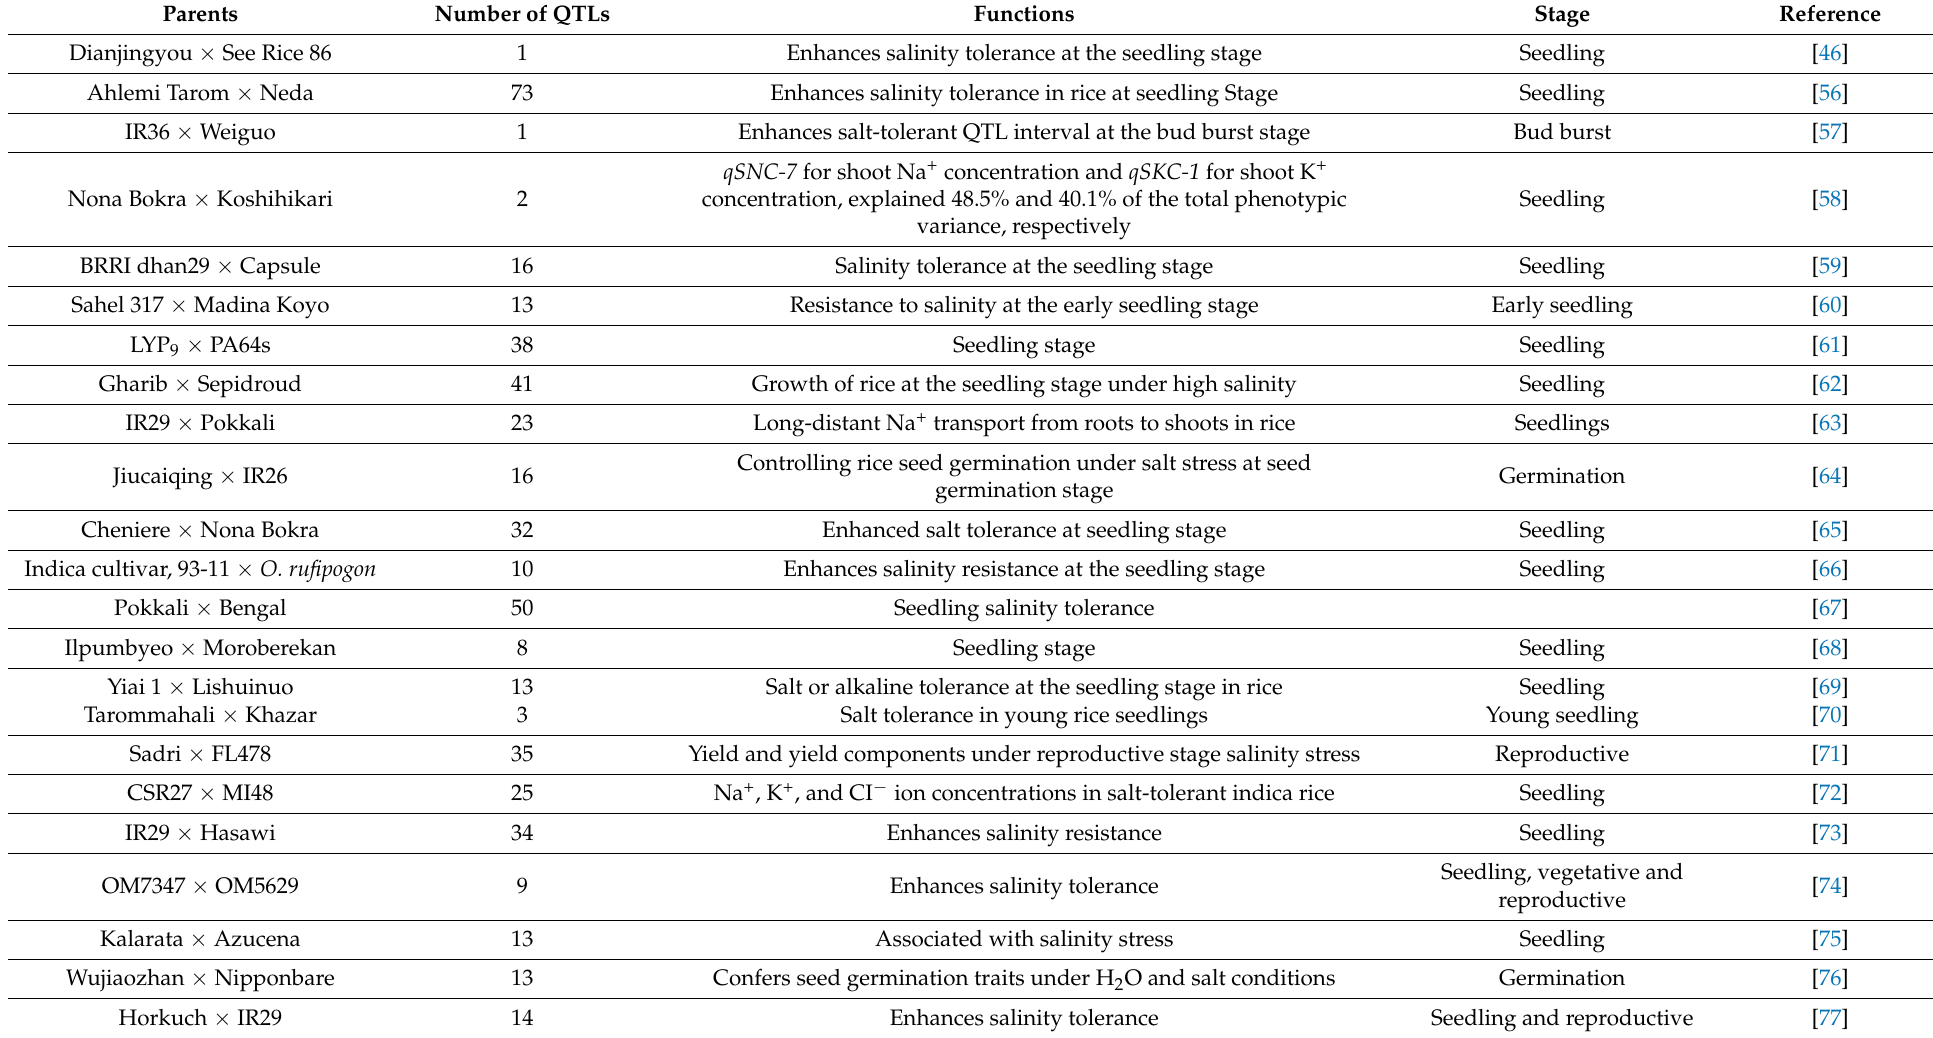
Table 1. List of QTLs mapped and identified in rice for salinity